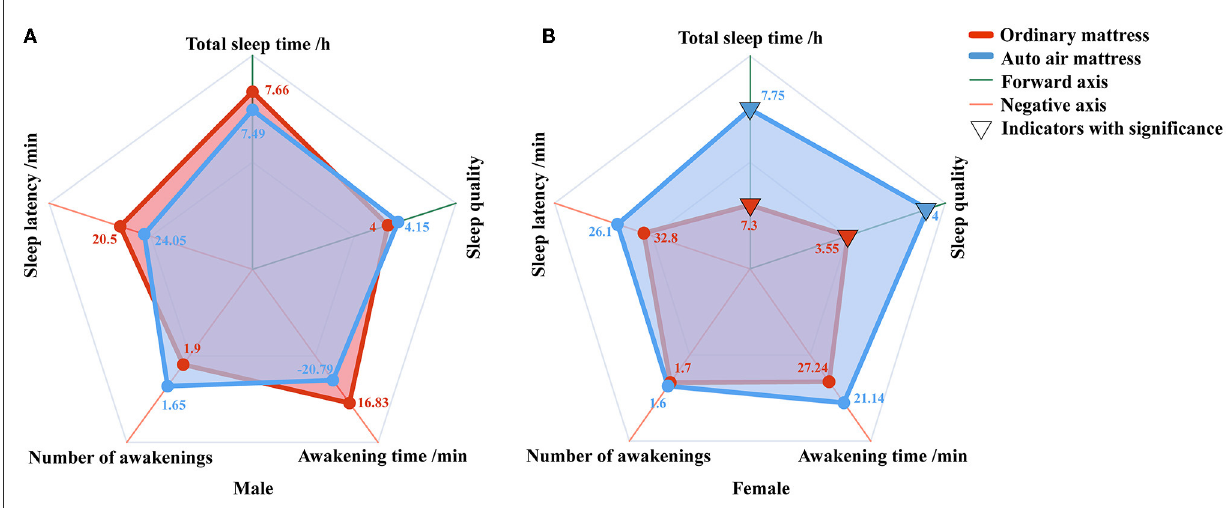
FIGURE3 The subjective sleep evaluation of the participants. (A) The subjective sleep evaluation of male participants. (B) The subjective sleep evaluation of female